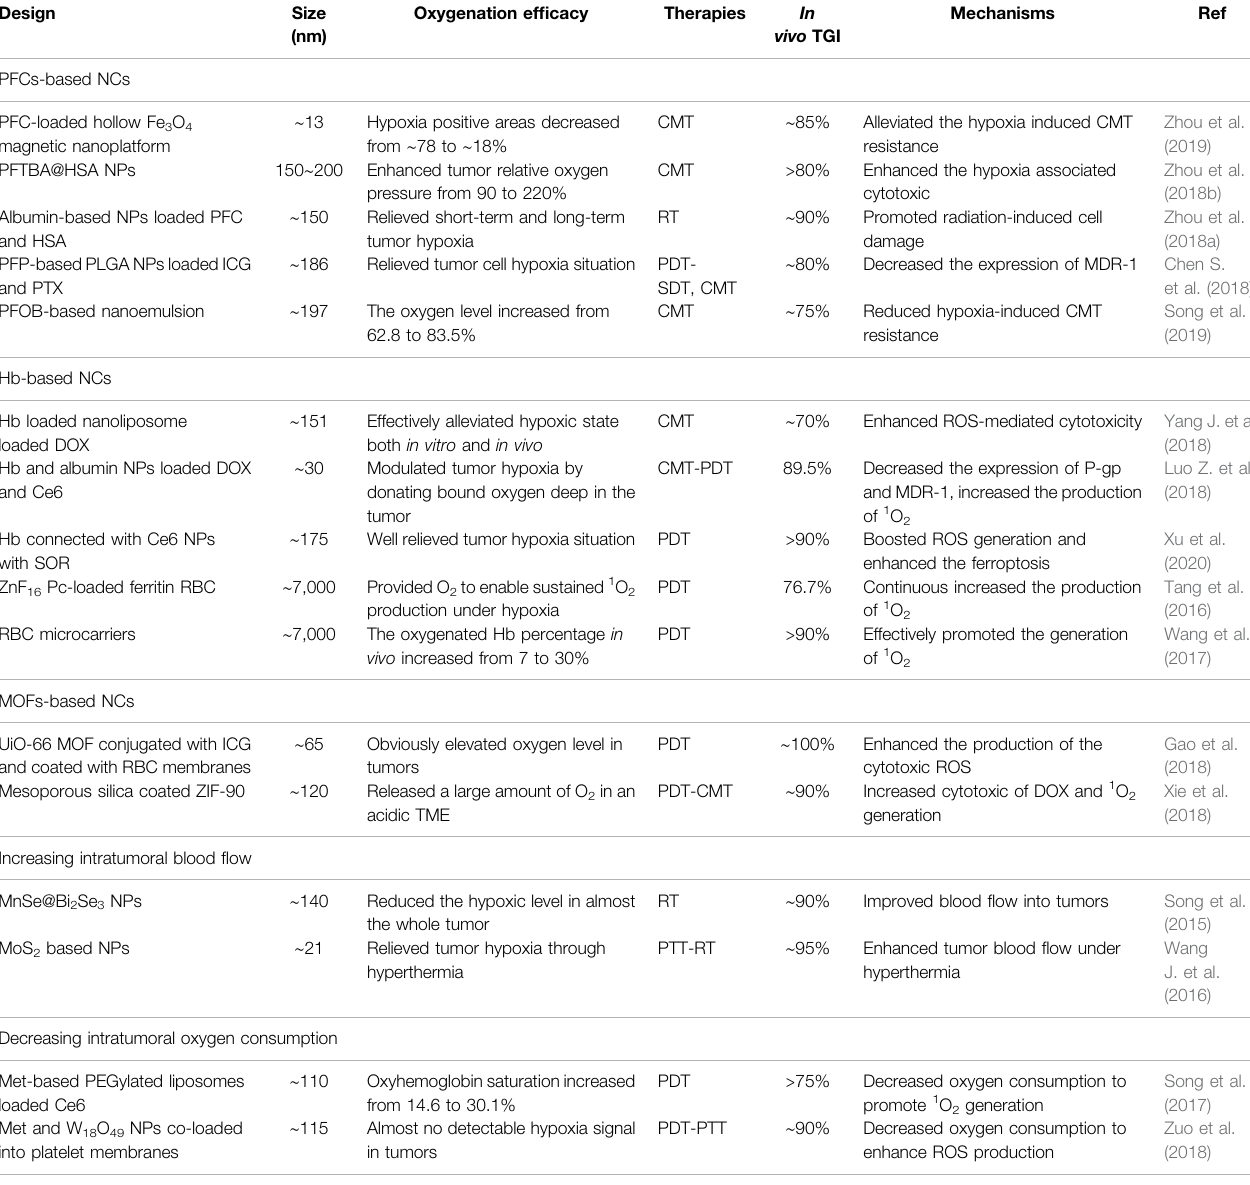
TABLE 4 | Oxygen carrying NCs to modulate tumor hypoxia for enhanced anti-tumor therapy.